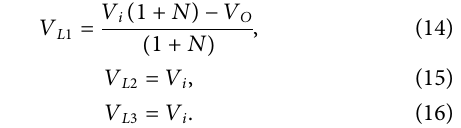
Mode 5: as shown in Figure 3E , the switches S 2 and S 3 are initially turned on, and S 1 is turned off. Current from the battery fl ows through the winding L 2 and switch S 2 , and through the winding L 3 and switch S 3 . The battery current also conducts L 1 , D 1 , L C1 , D 5 , C, and the load. The voltage equation is given as